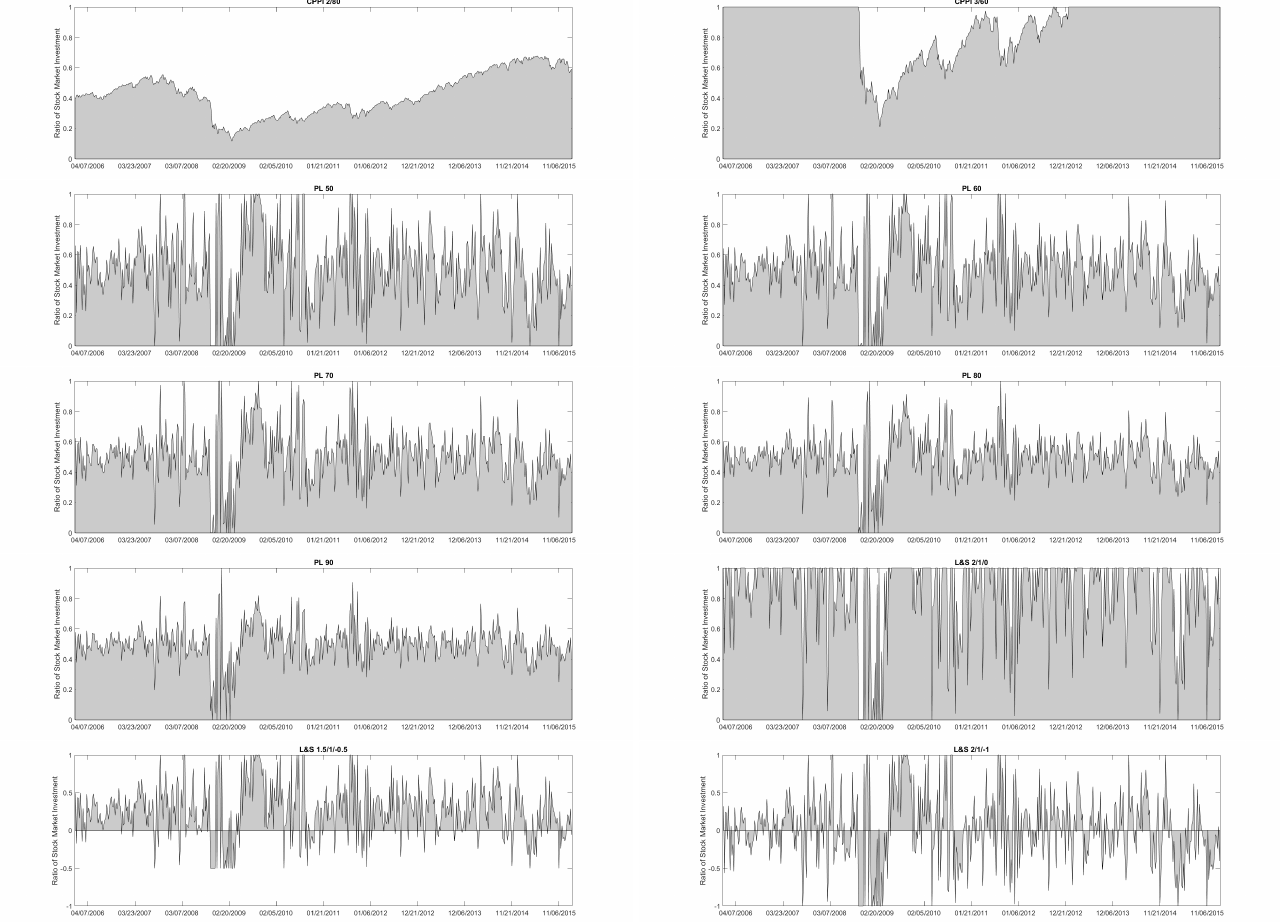
Figure A5. Percentage of total wealth invested in the S&P500 for diverse single-market trading strategies (CPPI, PL and L&S) over the out-of-sample period from 30 December 2005 until 5 February